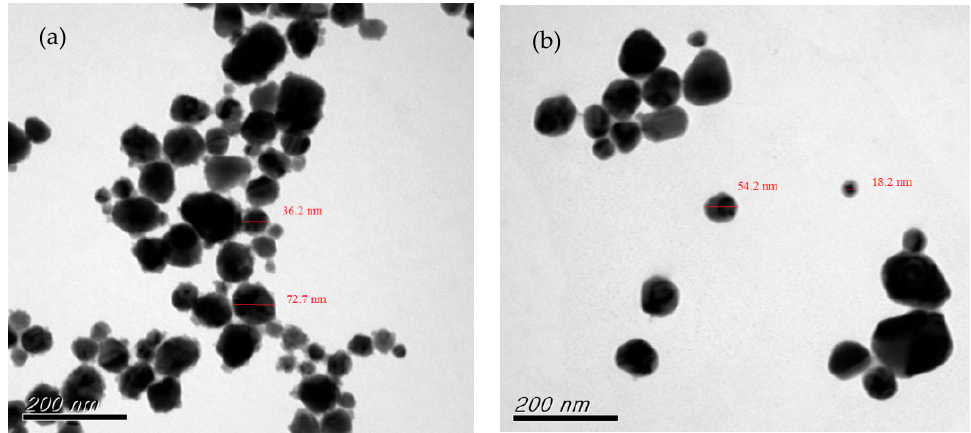
Figure 3. Primary reduction when (AA)/(CuSO 4 ) = 15: ( a ) pH = 11; ( b ) pH = 11.5.